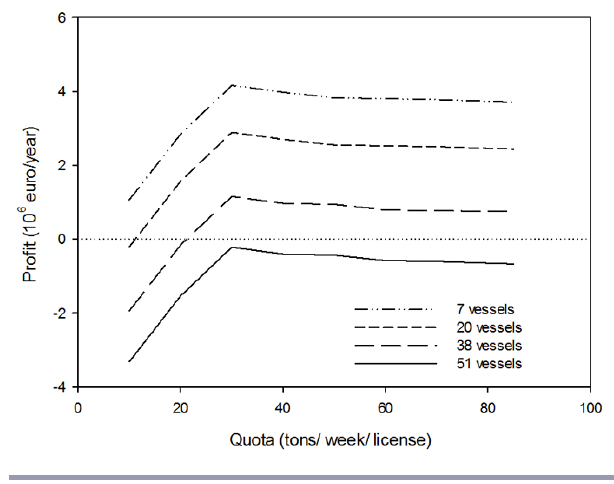
Fig. 7 . Model scenarios showing the effects of distributing 51 licenses among different numbers of vessels, and the effects of different quotas. Model scenarios are performed with a nutrient loading corresponding to the Water Framework